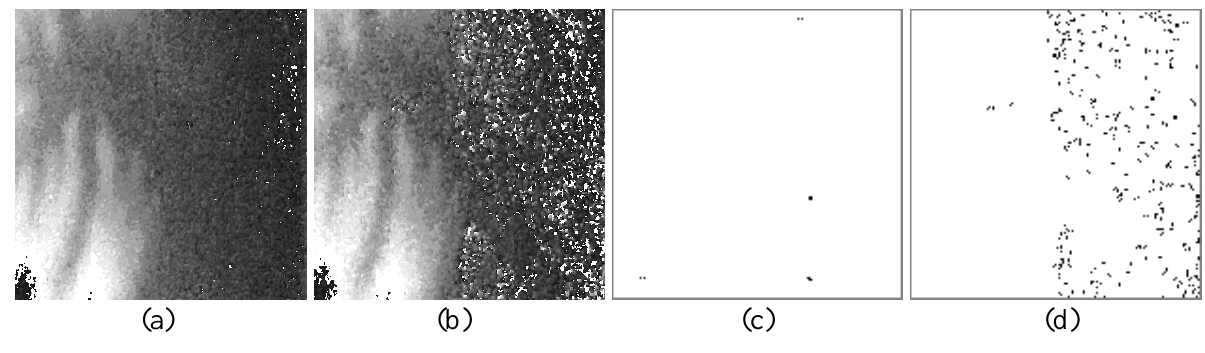
Figure 7. (a) The phase obtained by the AO method, which corresponds to the area from the frame in Figure 5(a). (b) The phase obtained by the CO2 method. (c) The residue map of the phase obtained by the AO method. (d) The residue map of the phase obtained by the CO2 method. All of them are in the ML case.